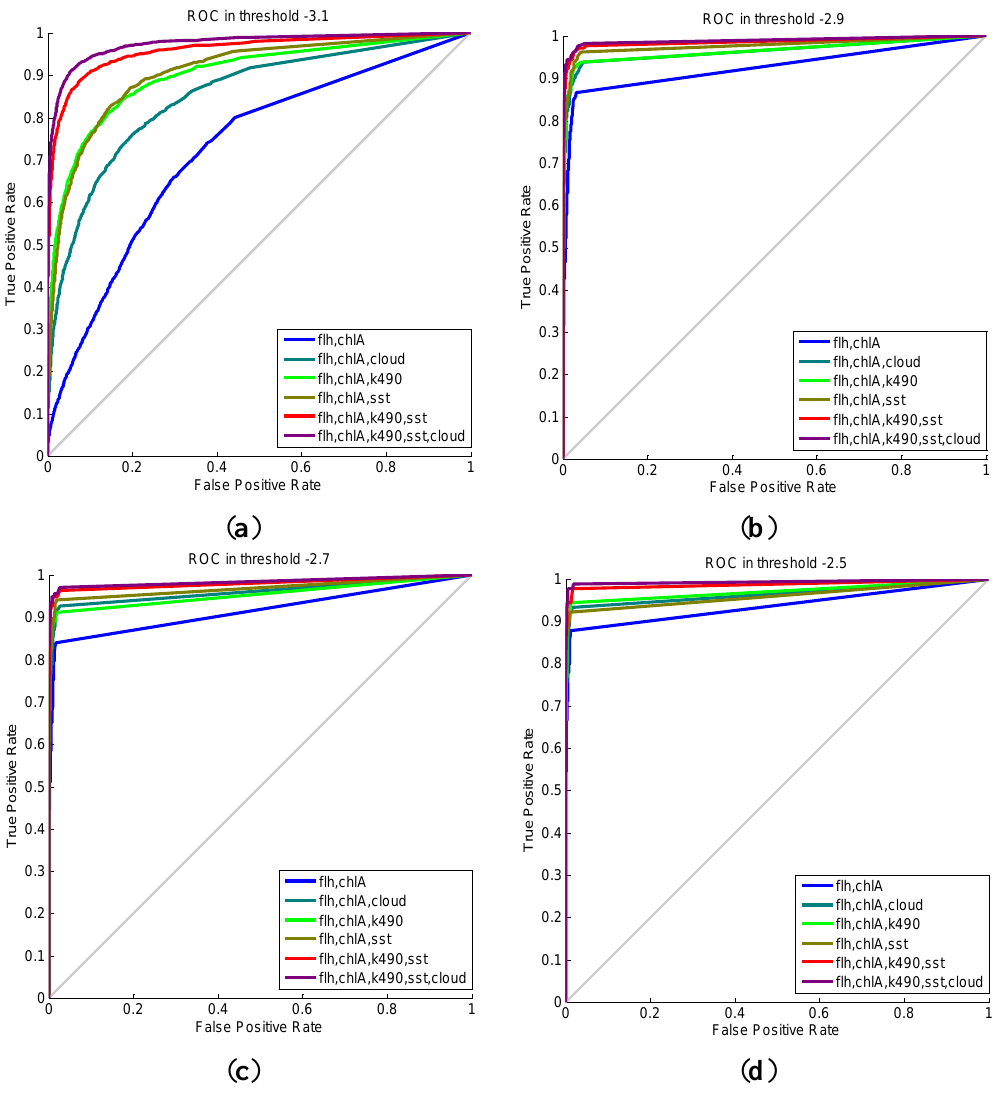
Figure 8. ROC curves based on RF in different MCI thresholds with various combinations of features. The MCI thresholds are on top of each subfigure ( a – d